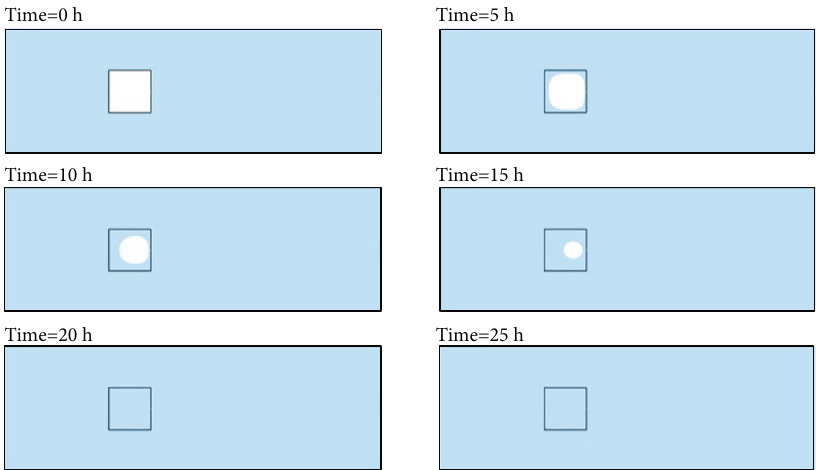
Figure 5: Liquid water saturation. E ff ectively, the areas with liquid water appear in blue whereas the areas of ice appear in white.